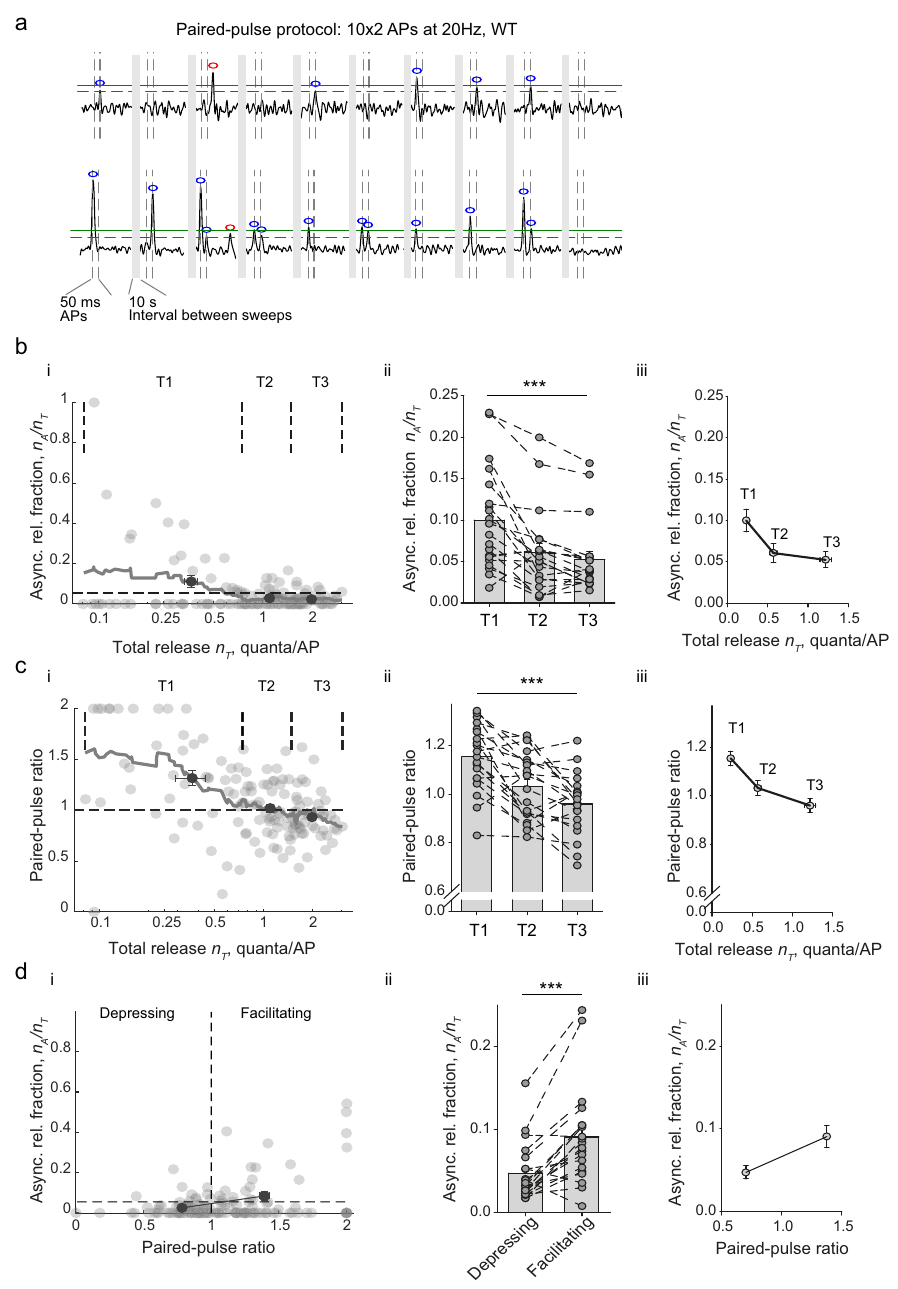
Fig. 4 Asynchronous release is elevated in parallel with short-term facilitation in low release ef fi cacy synapses. a Analysis of the relationship between short-term plasticity, synchronicity and ef fi cacy of glutamate release among synaptic outputs of single neurons. Paired-pulse stimulation paradigm and synaptic responses recorded in 2 representative boutons. As in Fig. 1, horizontal green lines show the amplitude of SF-iGluSnFR signal corresponding to the release of a single vesicle quanta ( q ). Vertical dashed lines depict action potential (AP) timings. Grey bars, 10 s intersweep intervals. Blue and red circles mark synchronous and asynchronous release events, respectively. b – d The relationships between: ( b ) asynchronous release fraction n A / n T and the overall release ef fi cacy n T , ( c ) paired-pulse ratio ( PPR ) and n T , and ( d ) n A / n T and PPR in (i) a represenrtative cell ( n = 137 boutons) and (ii, iii) across all recorded cells ( N = 20 cells from 7 culture preparations, each recorded neuron contained at least 50 boutons). (i) Vertical dashed lines mark the subdivision of boutons either according to n T (T1, T2 and T3, as in Fig. 3) or according to PPR (Depressing/Facilitating). Horizontal dashed lines depict either the average fraction of asynchronous release or the average PPR . Black dots with error bars depict average values within each group (mean ± SEM). (ii) Bar and dot summary plots (mean ± SEM), data from individual cells are connected by dashed lines. (iii) Average values in each group among all recorded cells (mean ± SEM). *** p < 0.001, repeated measures ANOVA ( b and c ) and two-tailed paired t -test ( d ) (for exact p values, all pairwise multiple comparisons, and further details of statistical analysis see SourceData.xlsx fi